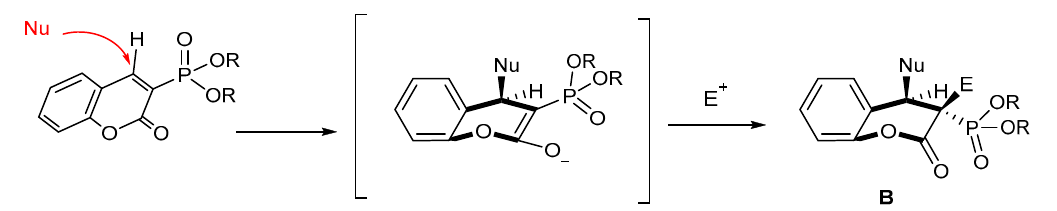
Figure 4. Nucleophilic addition reactions to 3-dialkylphosphonocoumarin.